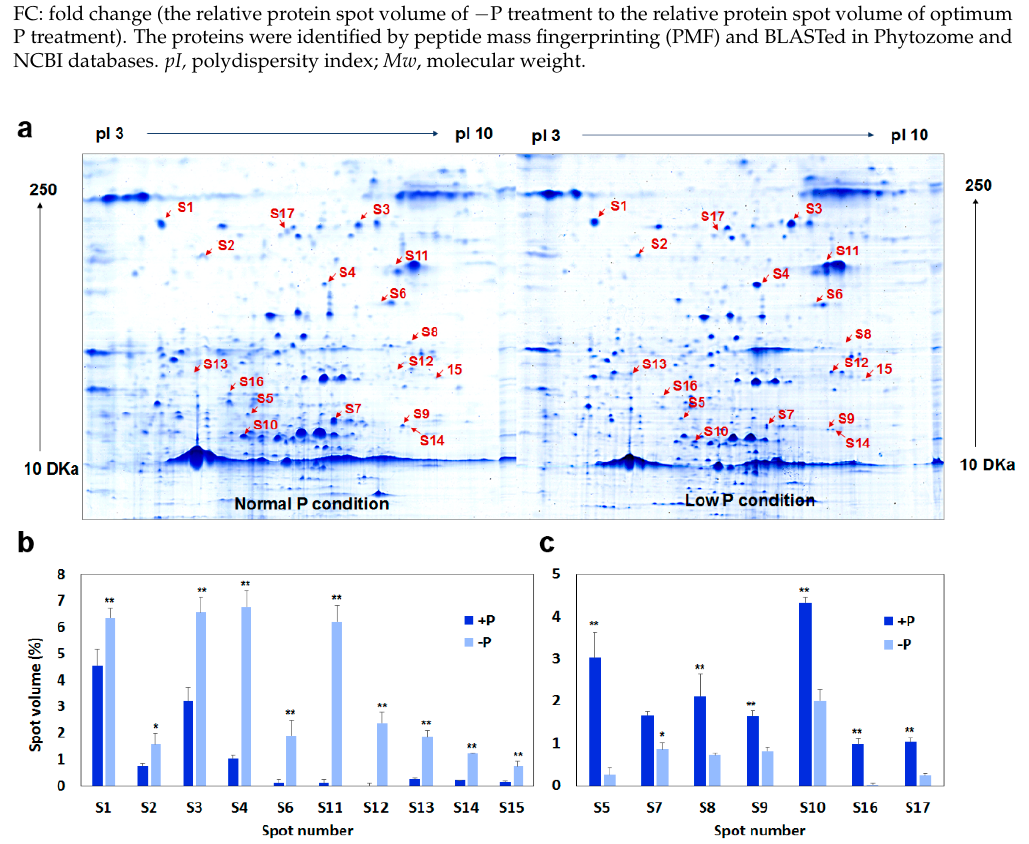
Figure 4. Representative CBB-stained 2D-IEF/SDS-PAGE gels of proteins extracted from soybean leaves grew at low-P condition ( − P, 5 µ mol KH 2 PO 4 ) and control (optimum P, 1000 µ mol KH 2 PO 4 ) ( a ) and the relative spot volumes of the 17 significantly increased ( b ) and decreased ( c ) protein spots in low-P stress and control leaves of soybean. Bars represent means ± SD. Student’s t -test was used to compare significance. * and ** denote significant low-P treatment differences at p < 0.05 and 0.01, respectively.